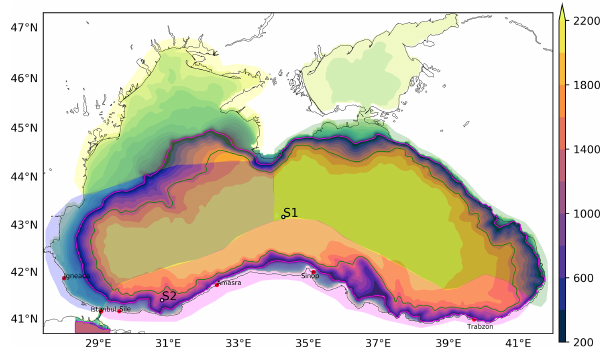
Figure 1. Model domain and bathymetry. The polygons show three subregions of the Black Sea (namely “east”, “west”, “rim”) used to sample the Argo floats. Six tide gauges along the Turkish coast are shown by red dots (˙I˘gneada, ˙Istanbul, ¸Sile, Amasra, Sinop and Tra- bzon). Contours in the range 100–2300m (contour interval 200m) correspond to the color scale on the right. Contours in the depth range 0–100m (contour interval 10m) are superimposed with dif- ferent color scale (not shown) and 100m contour marked in ma- genta. Two stations (S1 and S2) shown in white dots are used to construct time series